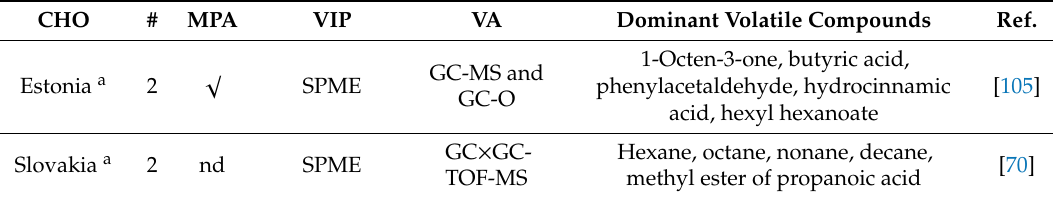
Table 16. Raspberry honey’s main volatiles, with reference to the country of origin, number of samples, isolation and analysis procedures and five main volatile components. Unless otherwise specified, the honeybee type was A. mellifera .